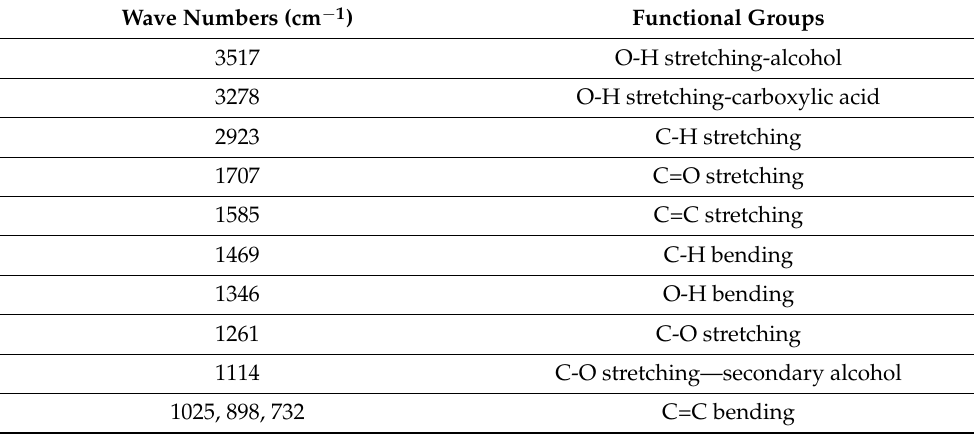
Figure 10. Fourier transforms infrared spectroscopy of treprostinil, blank patch, and optimized drug-loaded patch. Table 6. Absorption peaks of treprostinil observed in FTIR and its corresponding functional